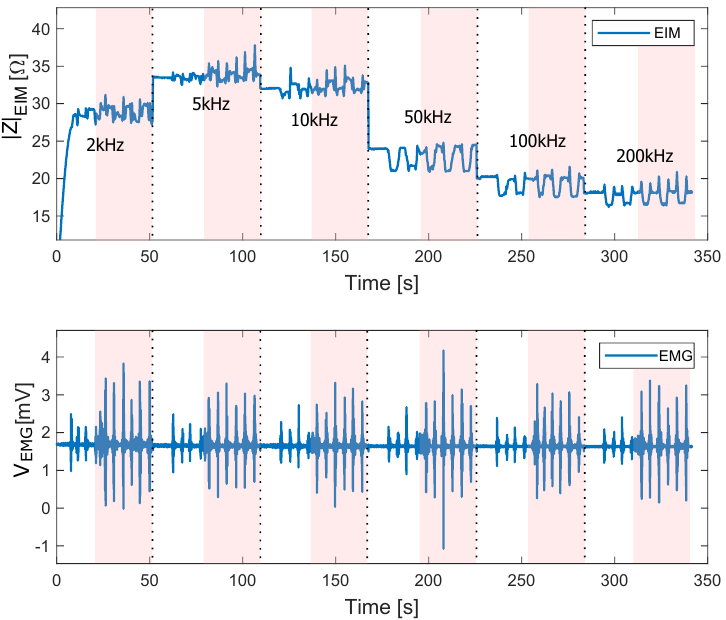
Figure 16. EIM and EMG at different frequencies during sit-to-stand with and without a weight of 15 kg attached to the back. The interval when the proband performed sit-to-stand cycle with 15 kg extra weight is marked in red. The sit-to-stand cycle without extra weight is marked in